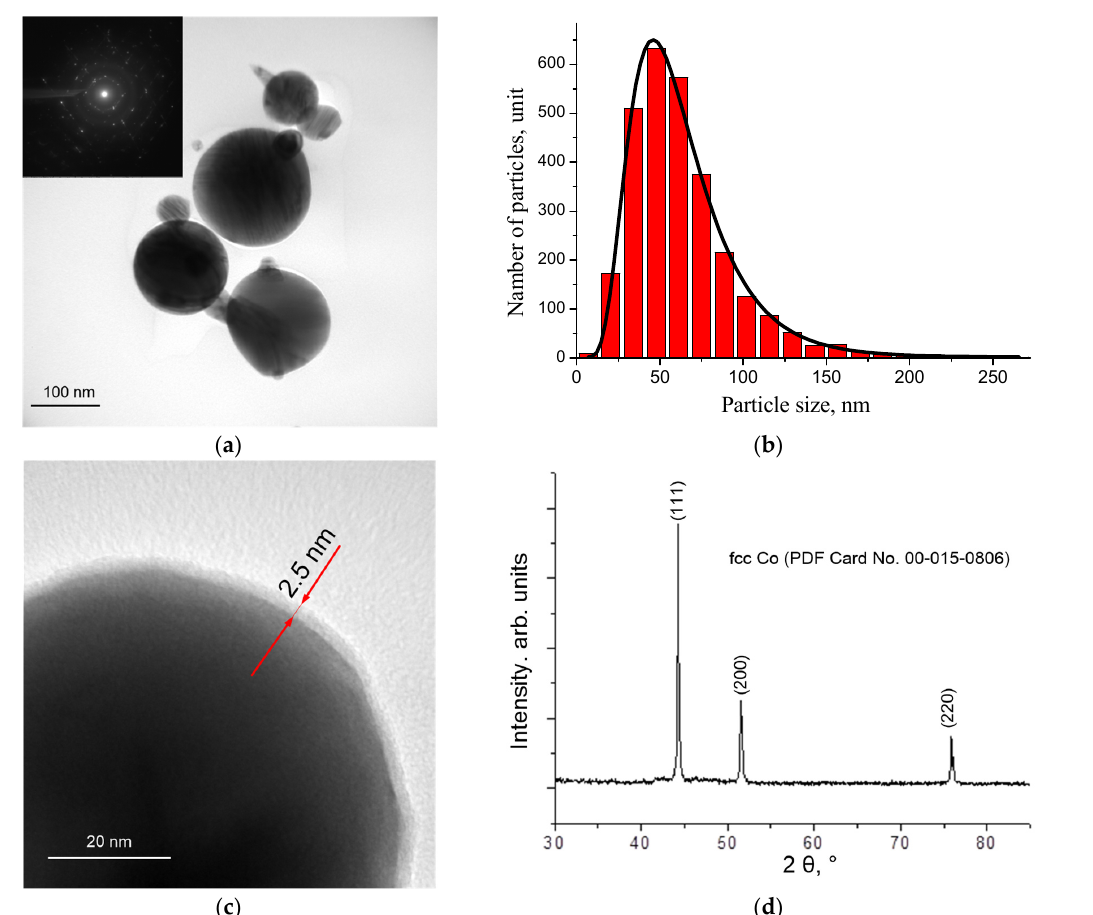
Figure 1. TEM image of cobalt nanoparticles ( a ), particle size distribution ( b ), TEM image of cobalt nanoparticles coated with oxide film ( c ) and X ‐ ray phase analysis data ( d ).